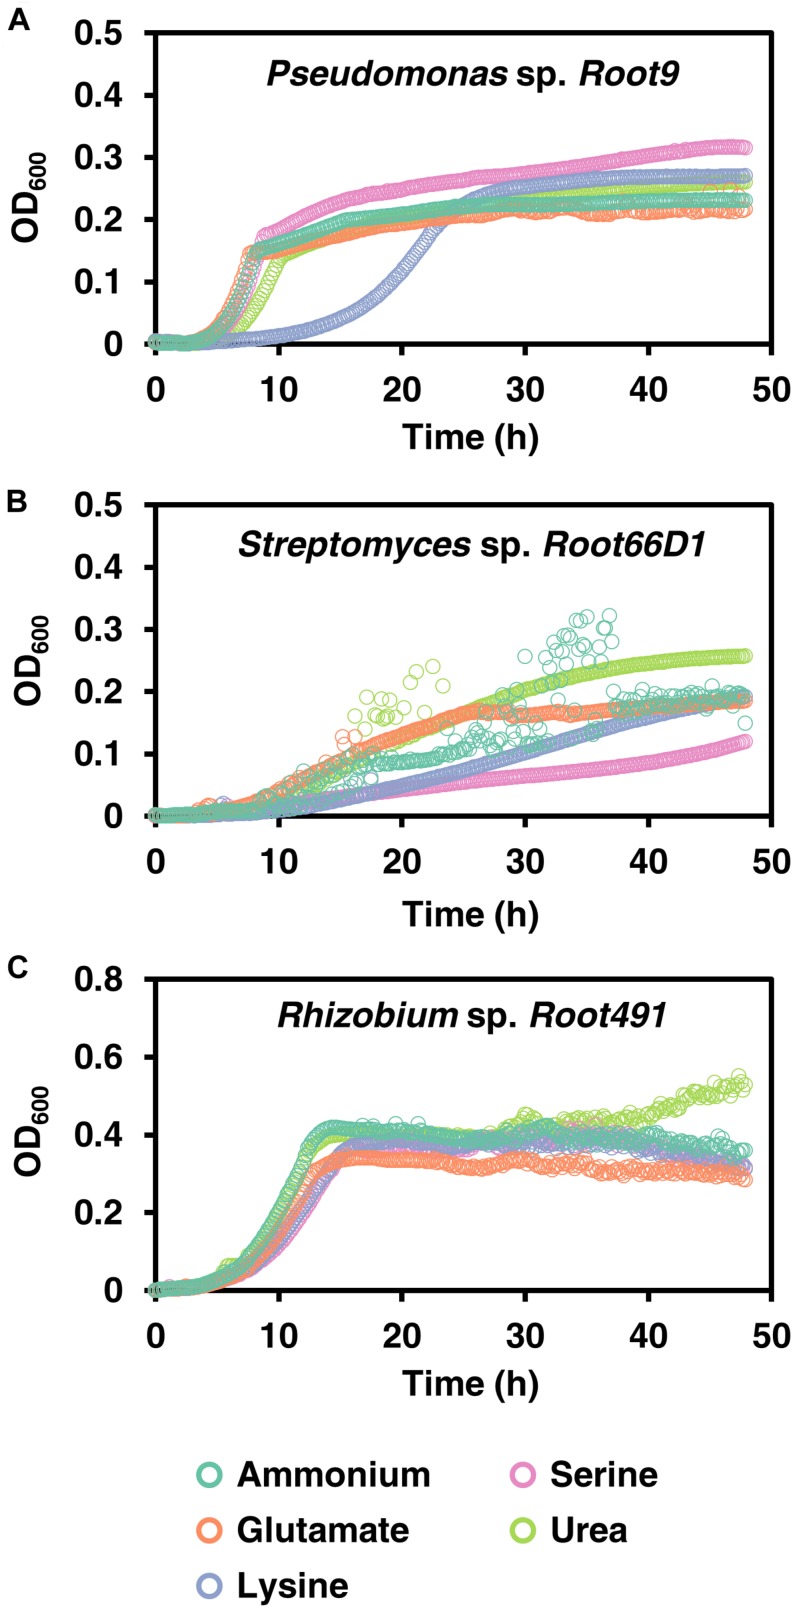
Growth curves on five nitrogen sources for three rhizosphere bacterial strains. (A)
Pseudomonas sp. Root9, (B)
Streptomyces sp. Root66D1, (C)
Rhizobium sp. Root491. Cultures were grown in 48-well plates on minimal medium containing a single nitrogen source. OD600 (uncorrected for path length) was logged every 10 min using a plate reader.